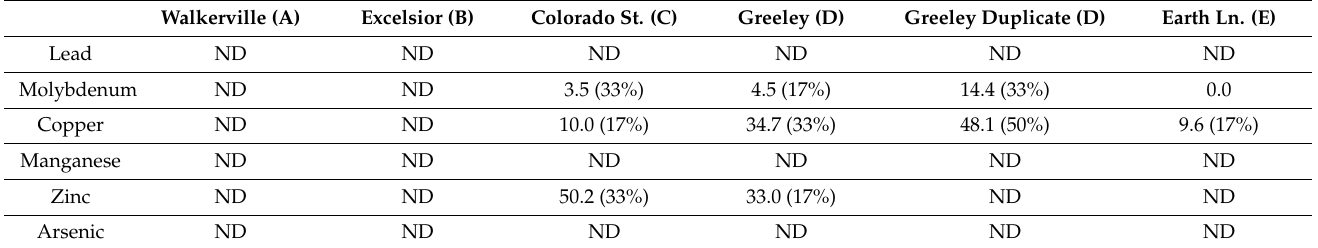
Table 1. Maximum elemental concentration ( µ g/m 3 ) measured using ICP-MS and collected during the PM 100 monitoring period. Values in parenthesis are percent detected. “Greeley” and “Greeley duplicate” are the same location monitored twice for quality control. Two sites (A & B) were non- detect (ND) for all